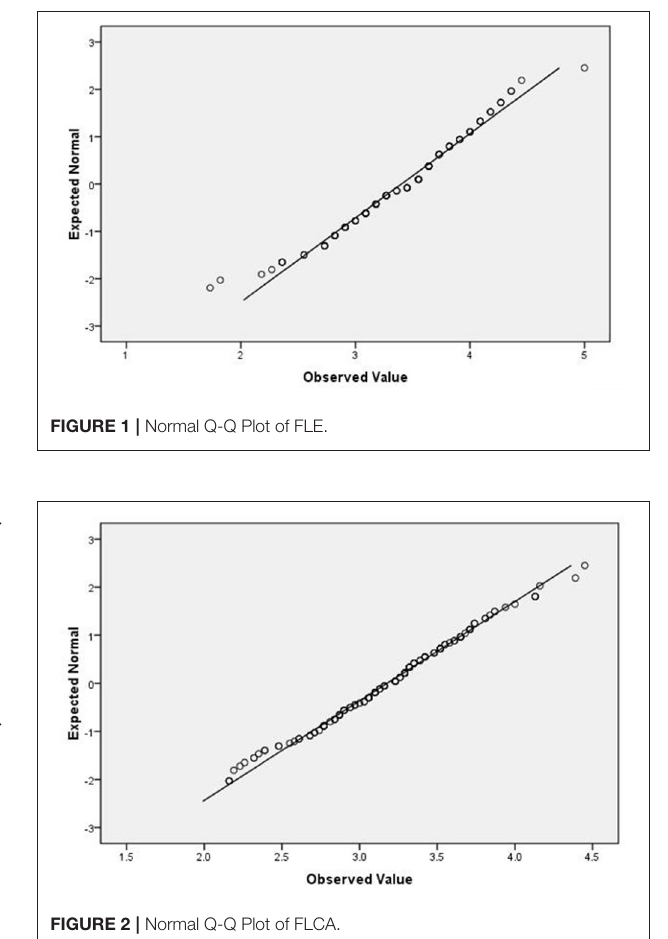
FIGURE 2 | Normal Q-Q Plot of